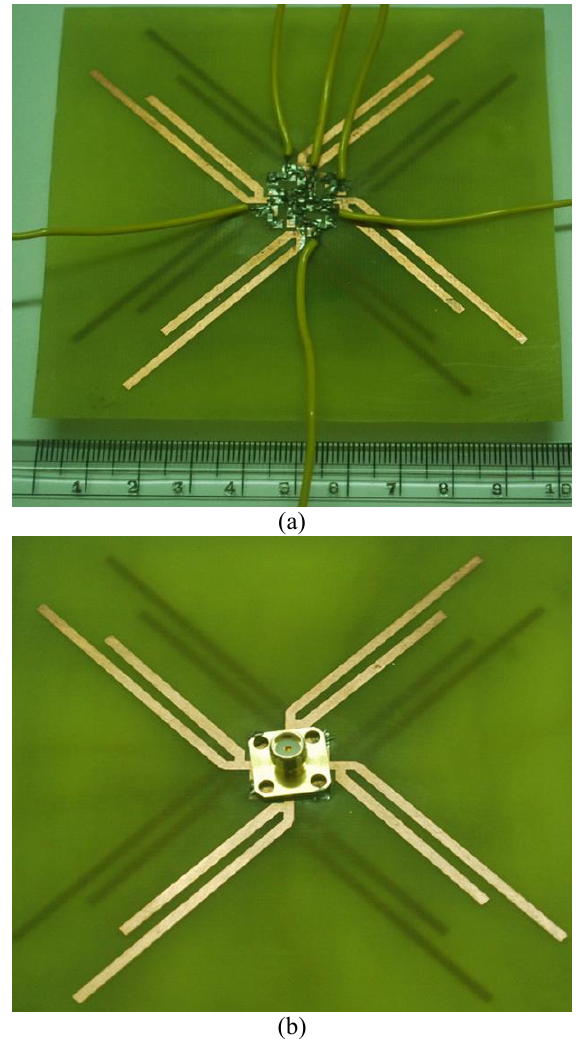
Figure 3: Photograph of the fabricated antenna (a) front view, (b) rear view.